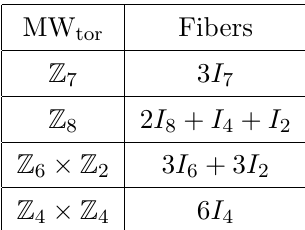
Table 3 . Summary of large torsion models, that cannot be realized in 3- and 4-folds and their singular (cid:12)bers. All of them are extremal